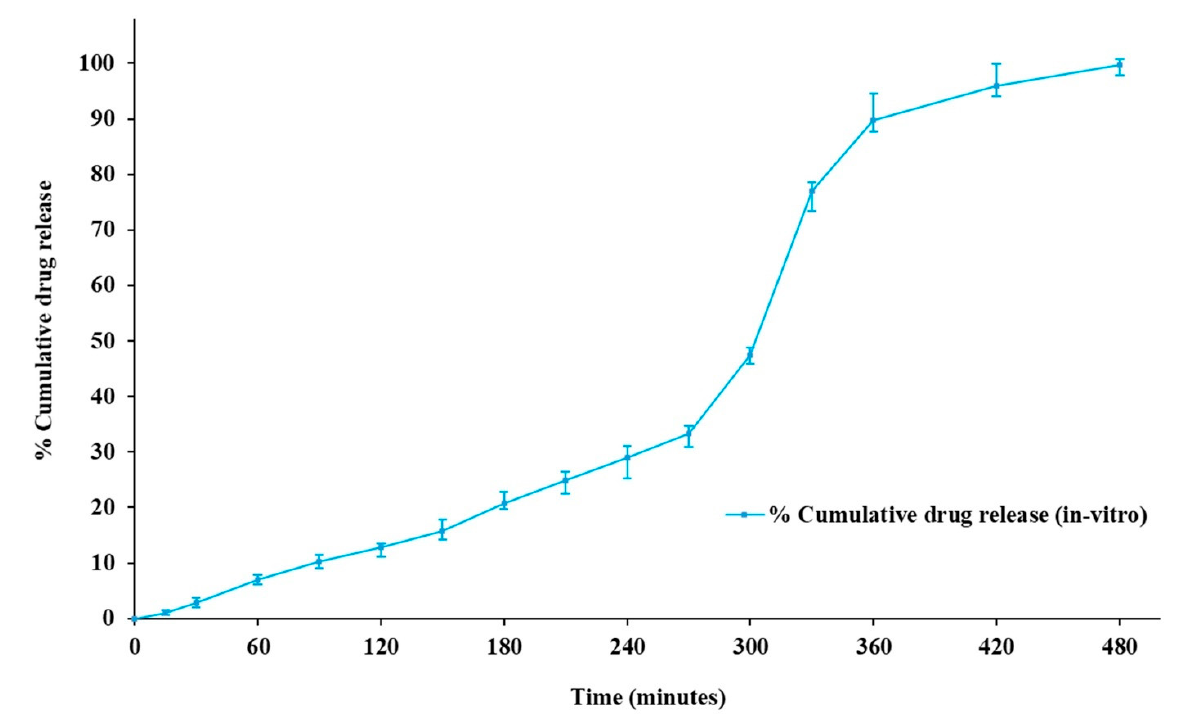
Figure 9. In vitro diffusion studies of optimized transemulgel formulation. Figure 9 . In vitro diffusion studies of optimized transemulgel formulation.